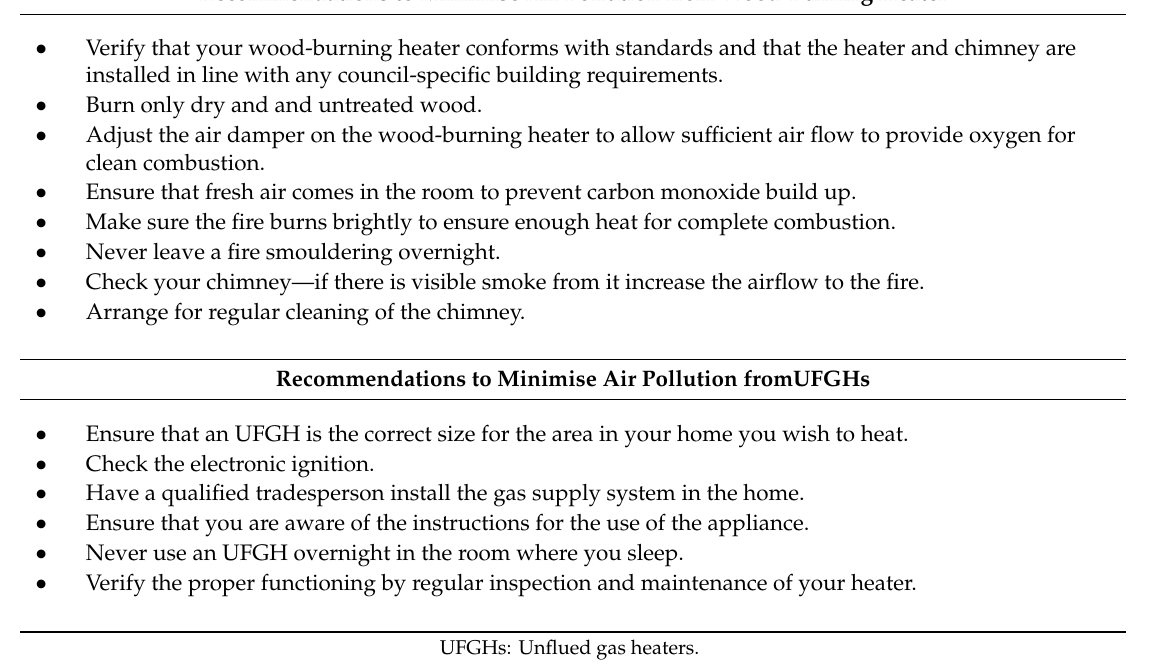
Table 3. Recommendations to minimise indoor air pollution from heating